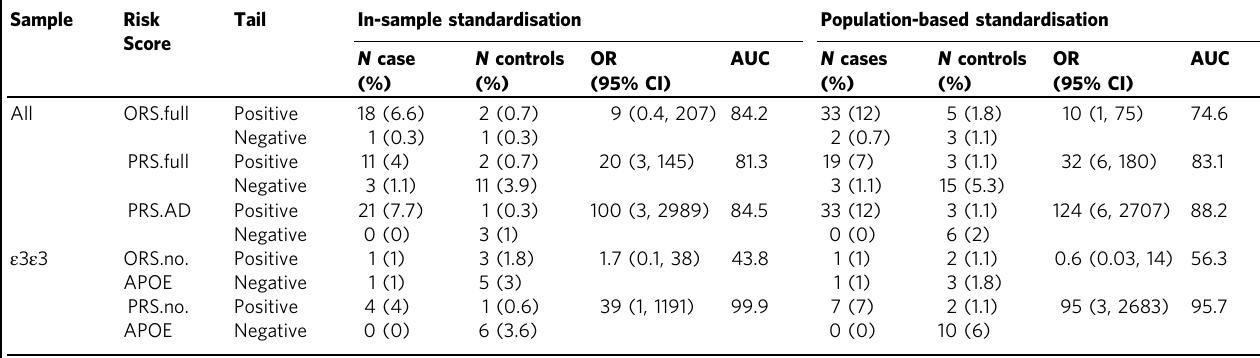
Table 3 Number of ORS/PRS extremes in the case-control dataset standardised within the sample and against 1000 Genomes European population. Sample Risk Tail In-sample Score